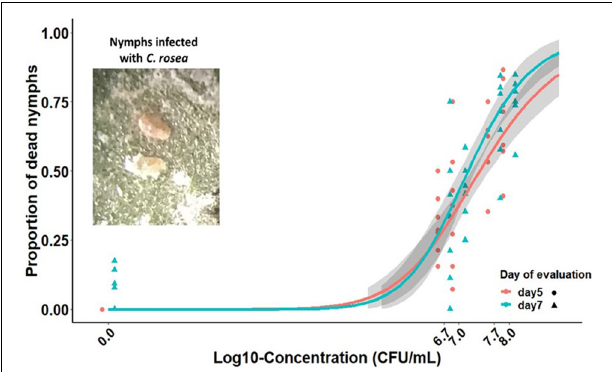
FIGURE 5 | Susceptibility of the first to second whitefly instar nymphs ( B. tabaci biotype B) to submerged conidia of C. rosea (strain CMAA1284) after 5 and 7 days of post-spraying. Typical dead nymphs due to infection of C. rosea are shown in the top left corner image. Solid lines represent fitted log-logistic curves describing the mortality and log 10 -concentration relationship, while symbols are data observations.